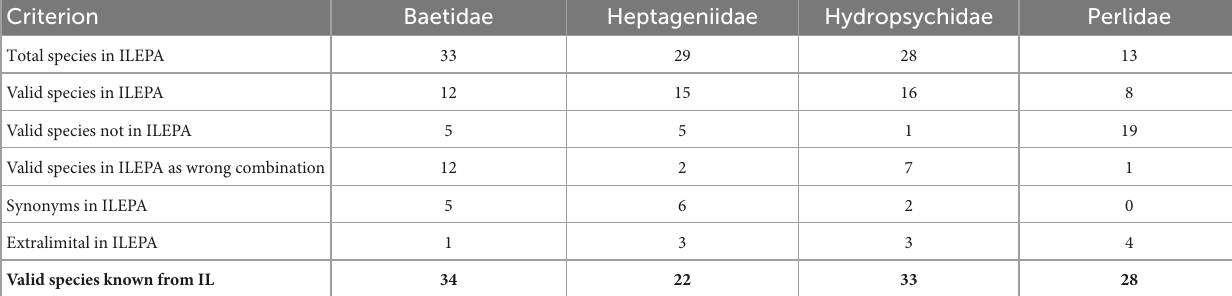
TABLE 1 Summary of species accounts from the Illinois Environmental Protection Agency [ILEPA] (2011a,b) database, and the “true pool” of valid species reliably reported as occurring in IL, constructed from museum collection records, literature records and databases of valid names.